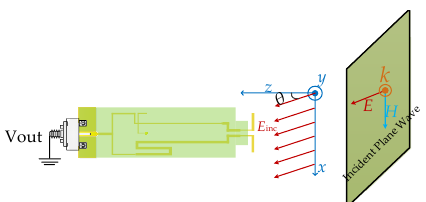
Figure 13. Simulated configuration of the selectivity of the tangential electric-field sensor.